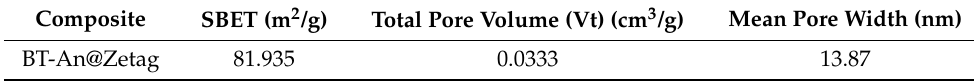
Figure 3. ( a ) N 2 adsorption/desorption isotherms curves of the BT-An@Zetag composite obtained from the nitrogen gas, and ( b ) the BJH pore size distribution of the BT-An@Zetag composite. Table 1. Textural parameters of the BT-An@Zetag composite. Table 1. Textural parameters of the BT-An@Zetag